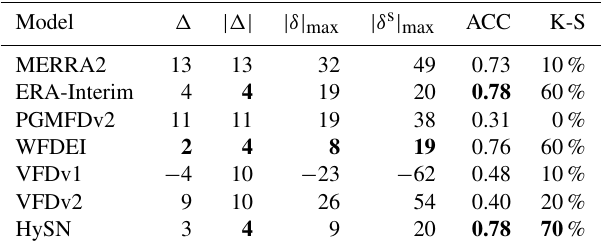
Table 4. As in Table 3 but with metrics listed for SW ↓ . Except for ACC and K-S, which are dimensionless, the units are given in Wm − 2 .